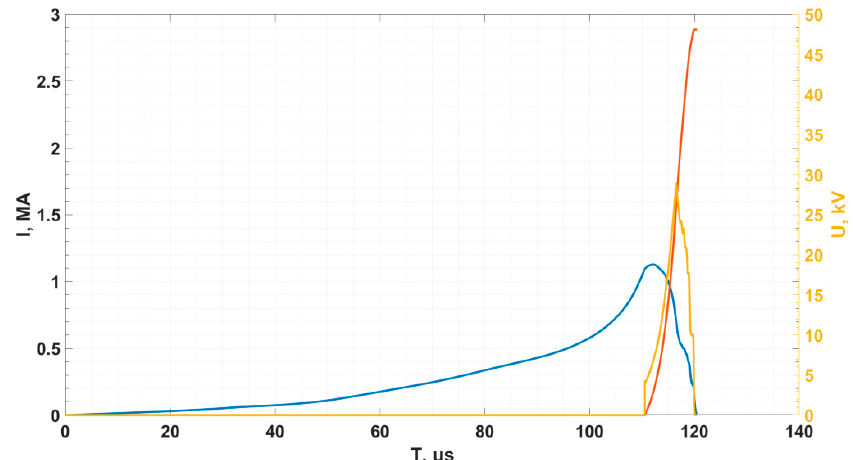
Figure 5. Calculated pulses of current in the load and load voltage during operation of the EMG. Blue— I b , current EMG; red— I L , load current; and yellow— U L , voltage on the load.